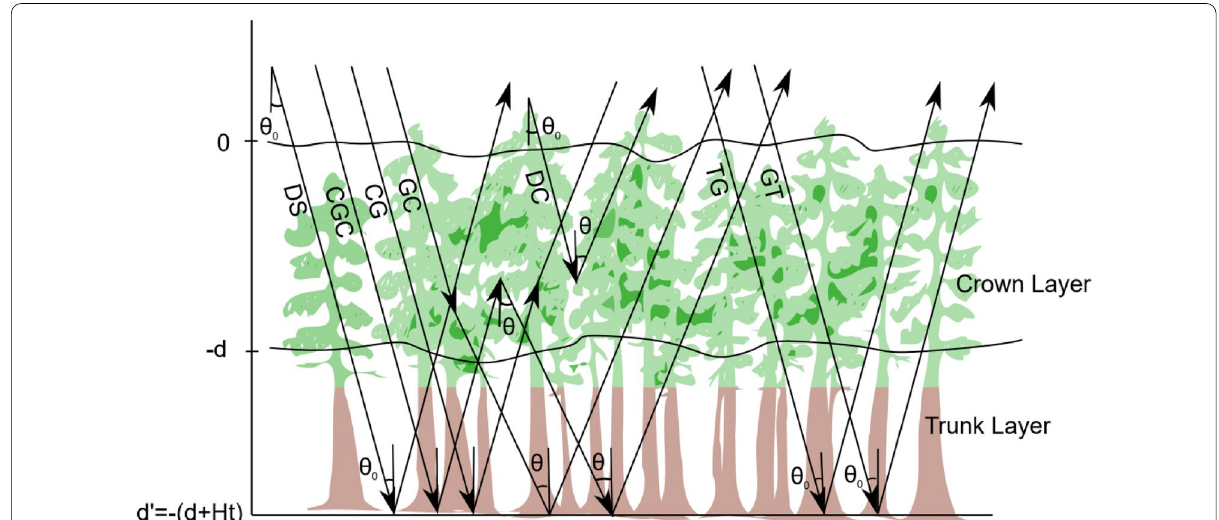
Fig. 2 Scattering mechanisms in the first-order MIMICS model, including the GCG, CG, DC, GC, GT, DG, and TG terms. The SG term is not shown. The crown layer depth is Z 1 d and the trunk layer depth Z 2 = =